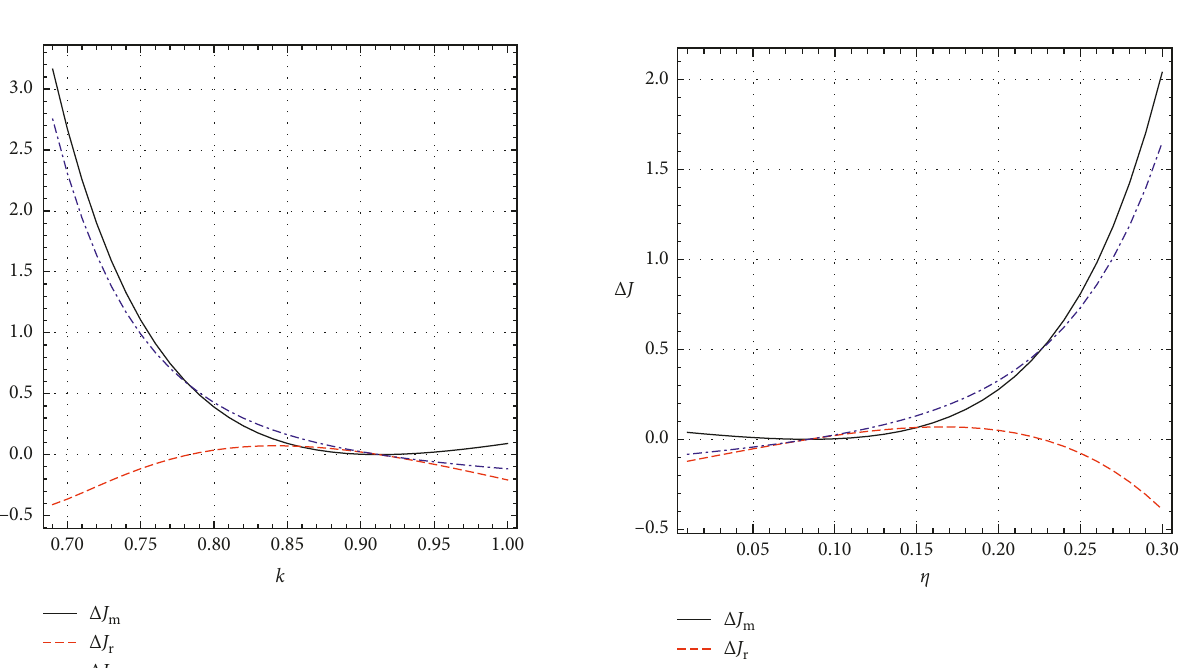
Figure 7: Comparison of steady-state decisions with η